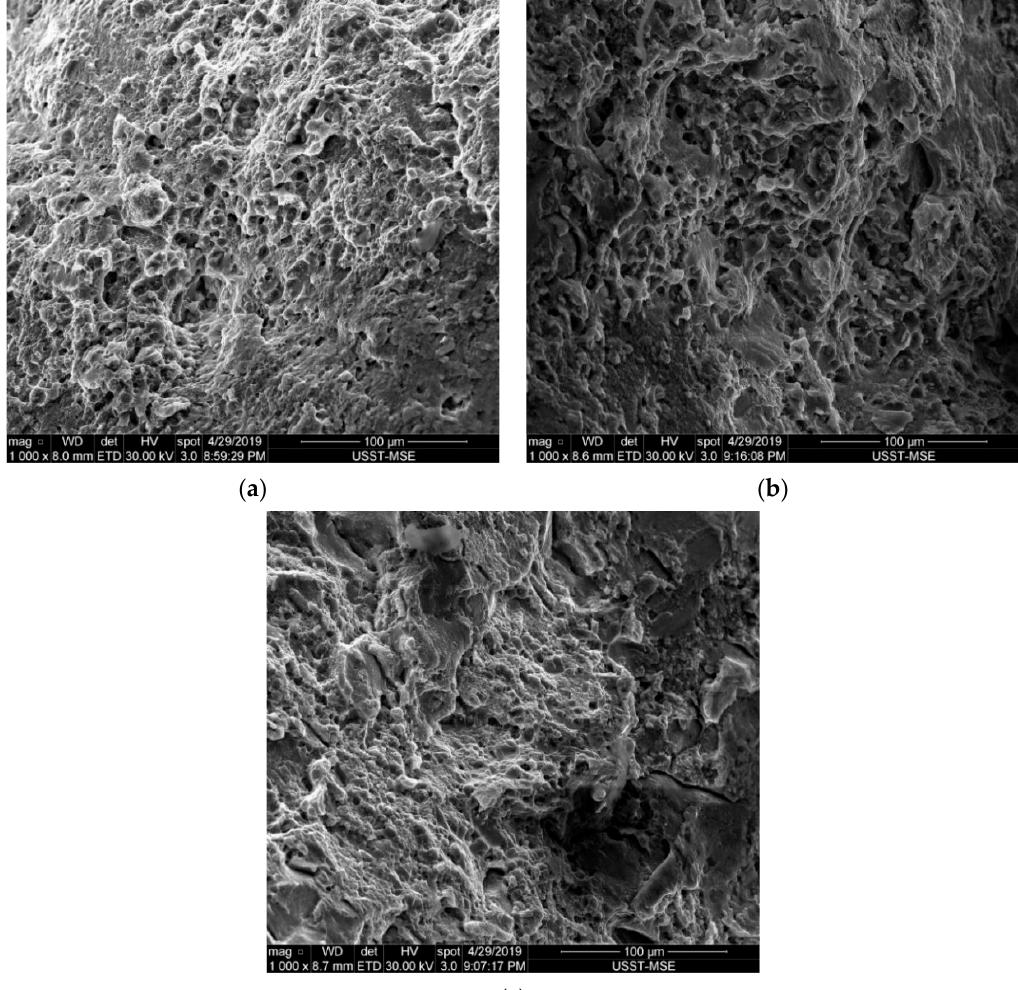
Figure 11. The typical fracture morphologies of the tensile specimens of squeeze-cast ZL205A under different ageing times: ( a ) 155 °C × 4 h; ( b ) 155 °C × 6 h; ( c ) 155 °C × 8 h.